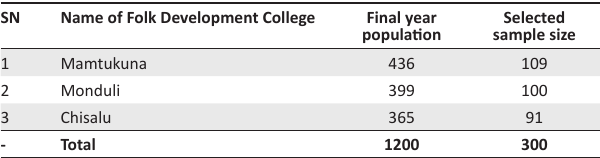
TABLE 1: Sample selection by